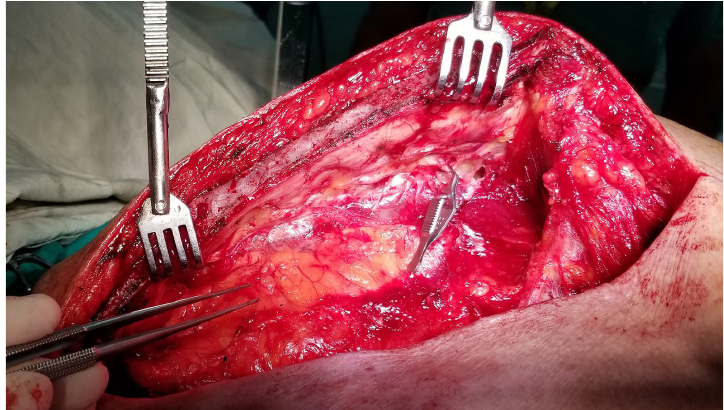
Fig. 4 -Pronounced elevation of the distal segment of the sternum will favor the dissection of the ITA bifurcation without risk of skeletal